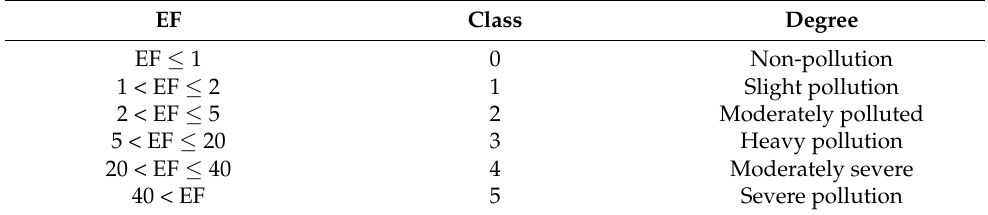
Table 1. Principle of grading for enrichment